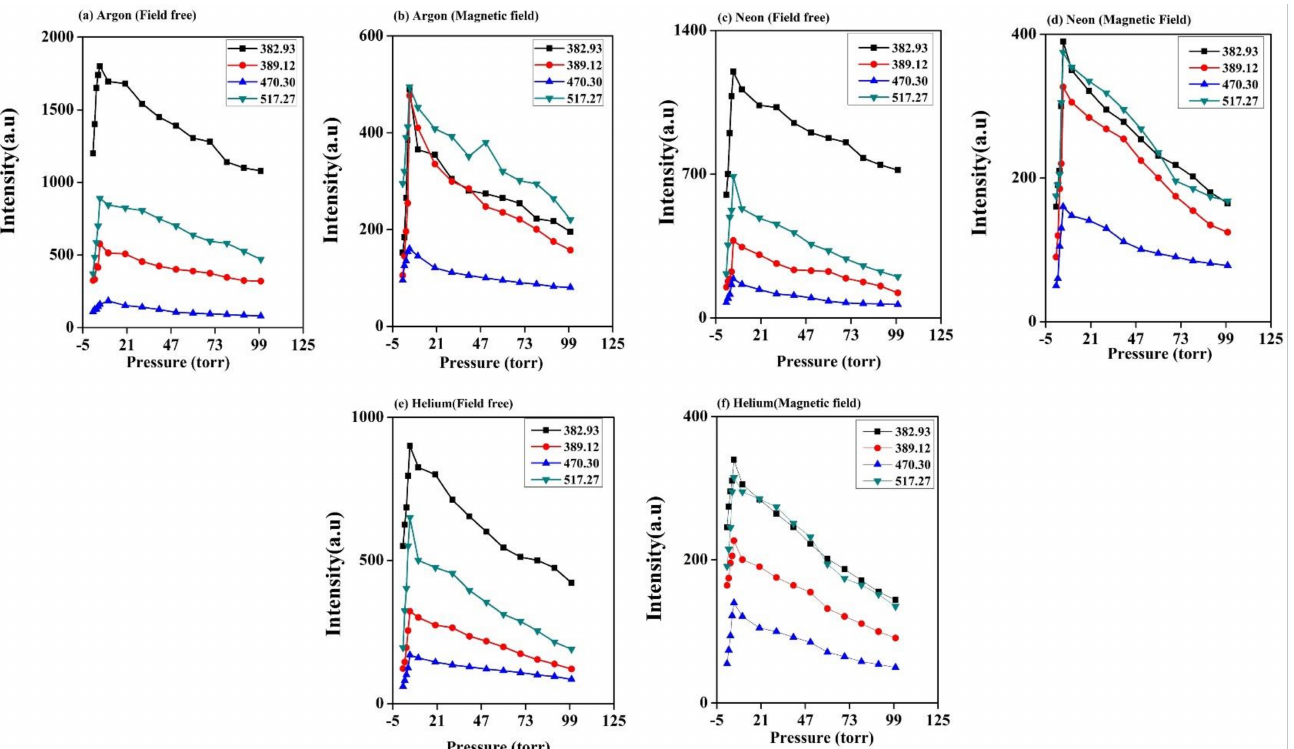
Figure 3. The spectral intensity variation of laser-induced Mg alloy plasma under several pressure levels of the inert gases Ar ( a , b ), Ne ( c , d ), and He ( e , f ) at 2 GW/cm 2